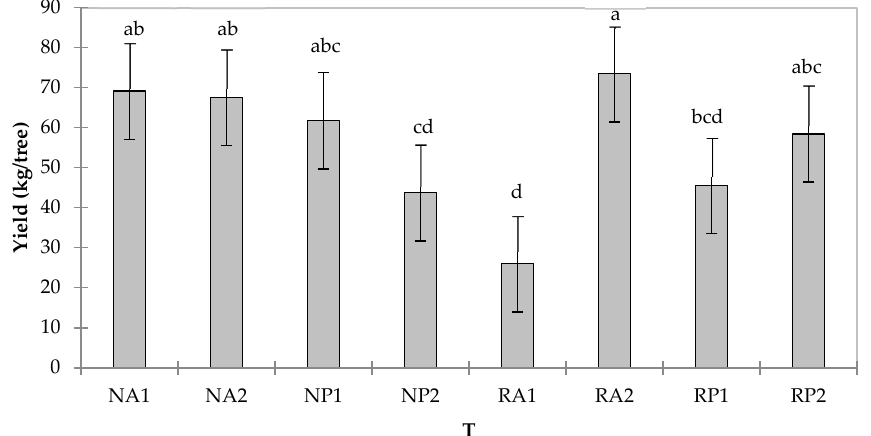
Figure 3. Yield (production average, kg/per tree) of Hass avocados in each orchard using 2 nutrient management practices during 2 production cycles. Different letters represent significant di ff erences